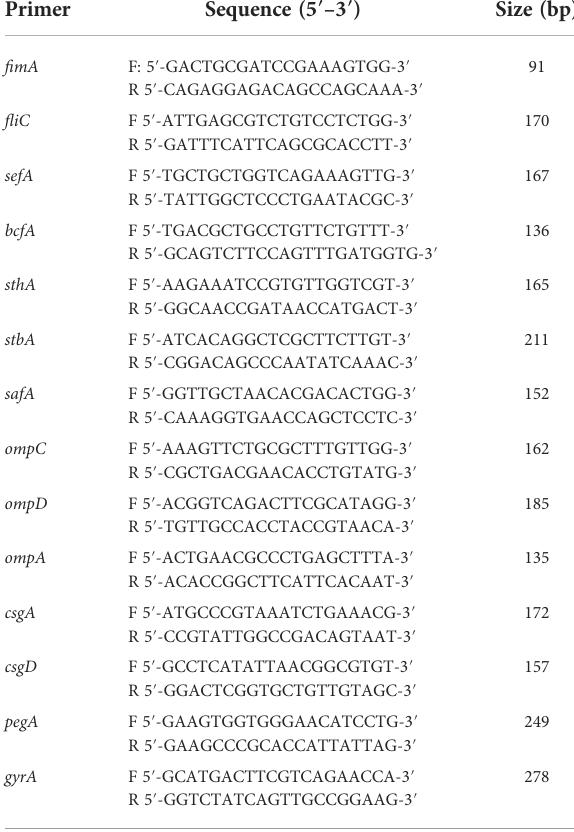
TABLE 2 Primers used for qRT-PCR analysis of the changes of virulence factors expression between MY1 and MY1 △ hcp strain. Primer Sequence (5 ′ – 3 ′